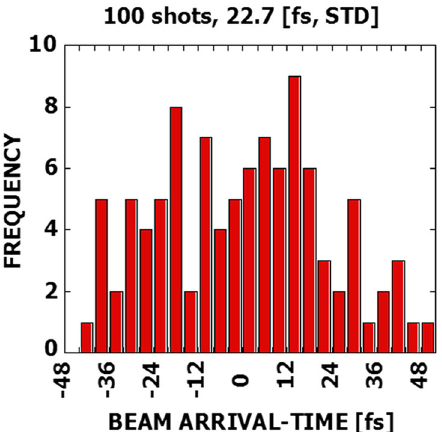
FIG. 31. Beam arrival time (movement of the center-mass position of the beam image) measured by the rf deflector system. The arrival-time jitter is 22.7 fs in STD.